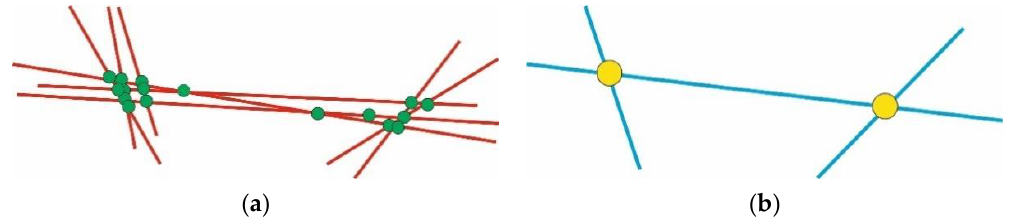
Figure 1. ( a ) Intersection points (green circles) of a trajectory (blue line) and its intersecting trajectories (red lines); ( b ) Resulting CP trajectory (blue line) with aggregated common points (yellow circles).